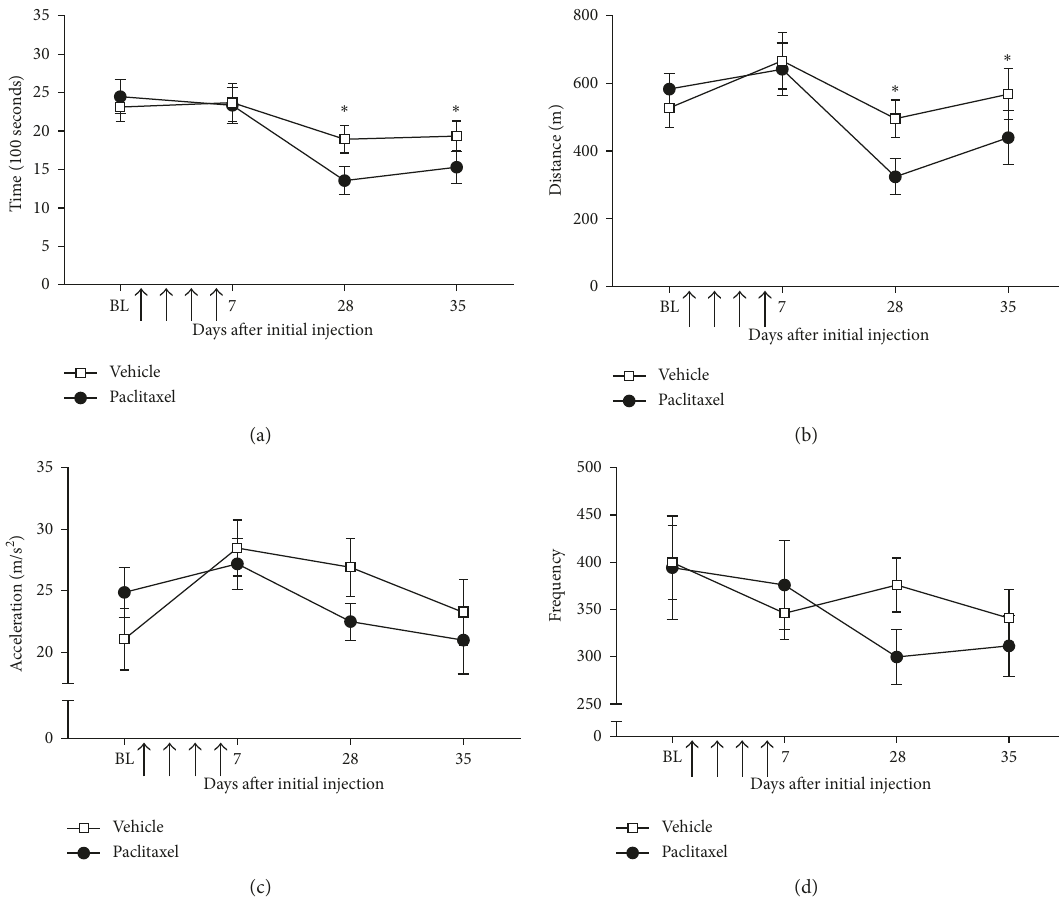
Figure 7: Effect of paclitaxel administration on overnight spontaneous wheel-running behaviour. Graphs show the mean spent on the wheel, (b) total distance travelled, (c) maximal acceleration generated, and (d) number of times the wheel was accessed by individual rats overnight (7.10pm–6.30am) before paclitaxel/vehicle administration (BL) and then on day 7, day 28, and day 35 following the initial injection of 2mg/kg paclitaxel or vehicle. Arrows indicate four injections of 2mg/kg paclitaxel or equivalent volume of vehicle on days 0, 2, 4, and